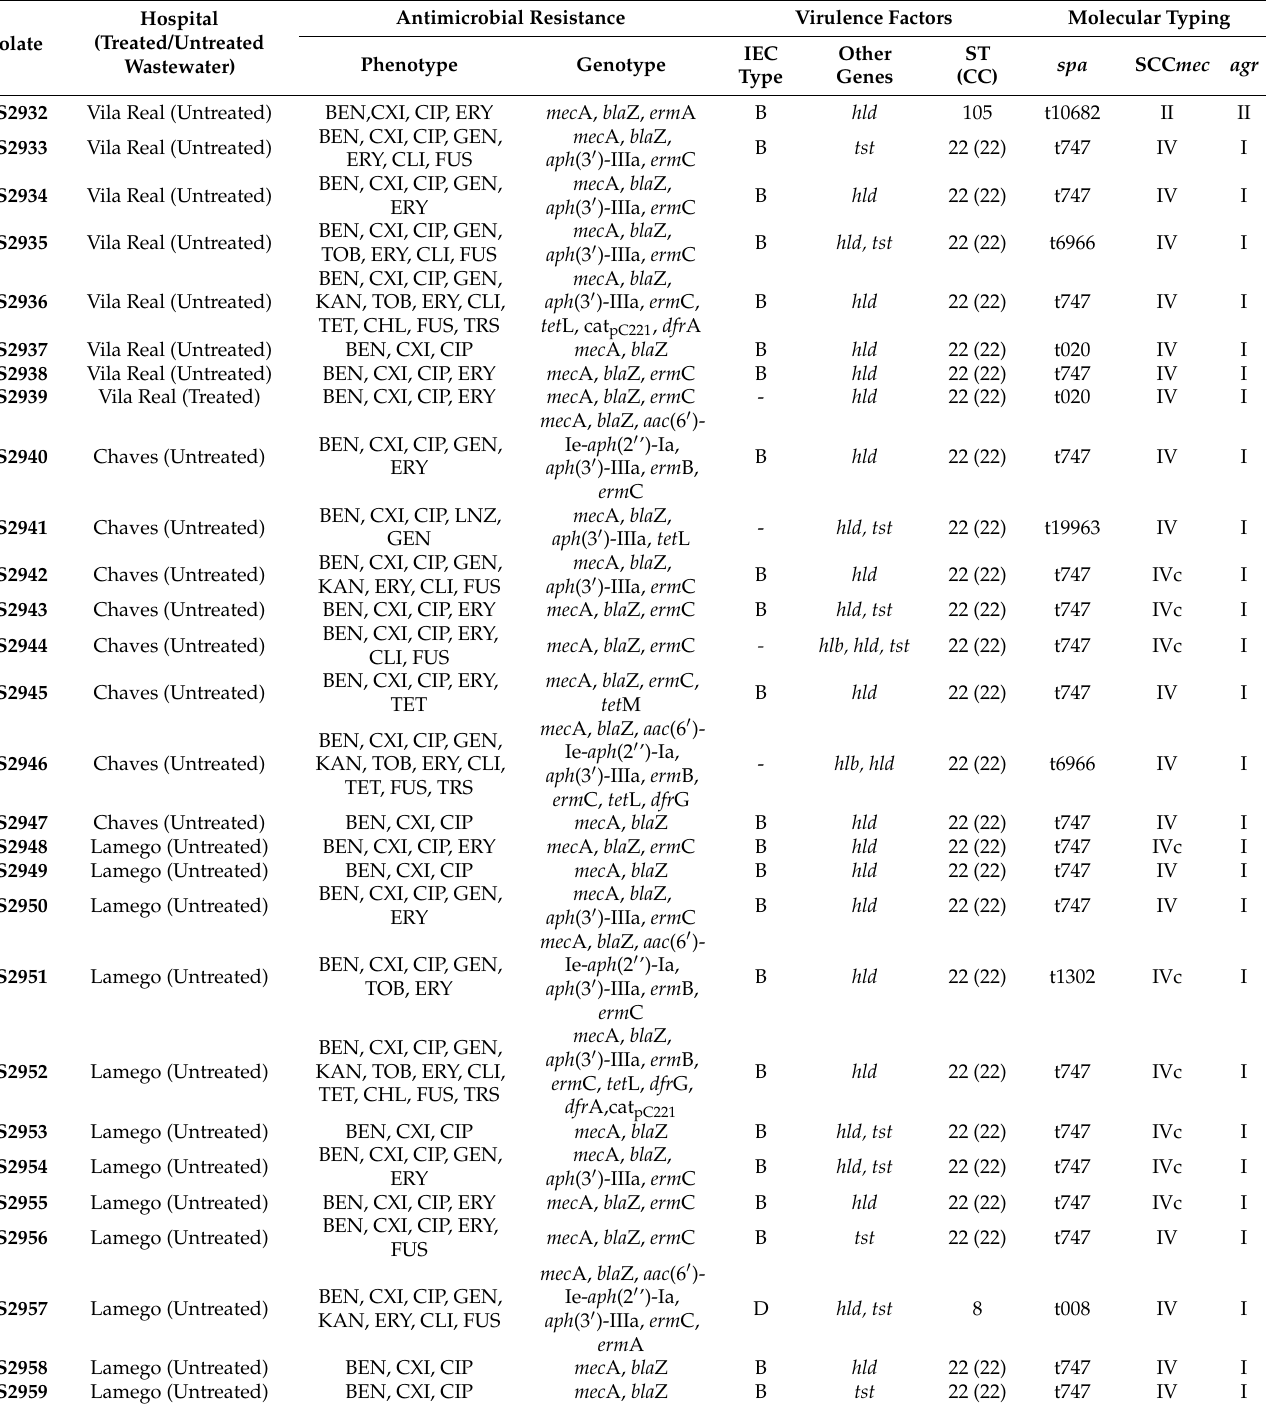
Table 1. Description and genetic characteristics of MRSA strains isolated from hospital wastewaters in